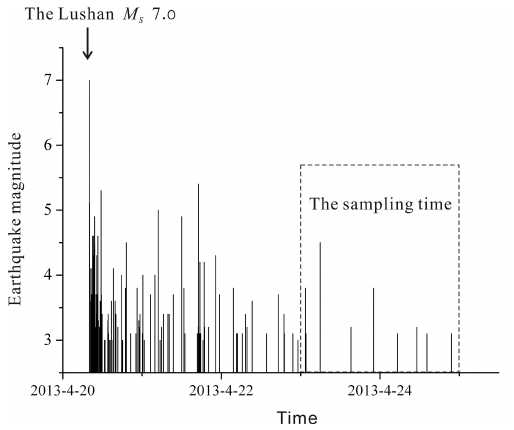
Figure 4. The aftershocks after the Lushan